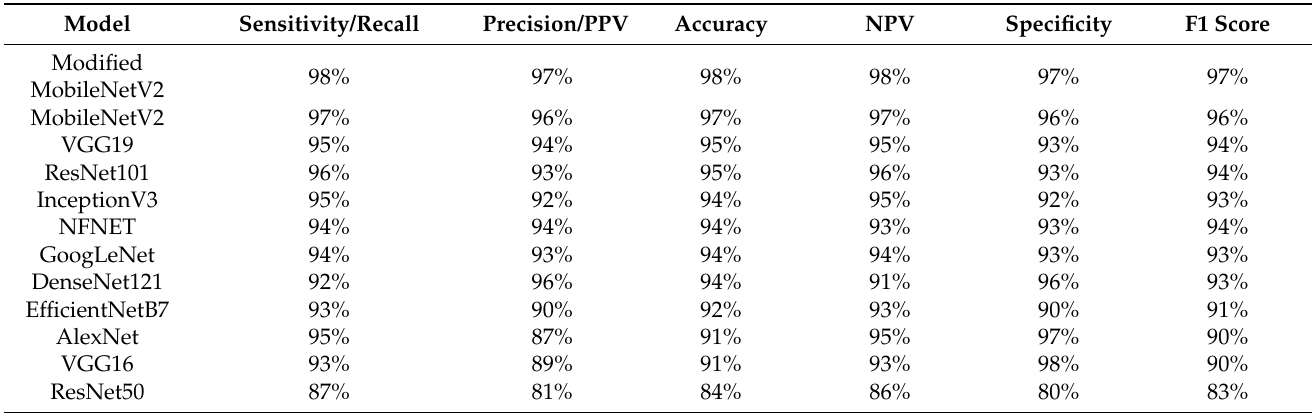
Figure 6. Confusion matrix of the models. Table 7. Model performance